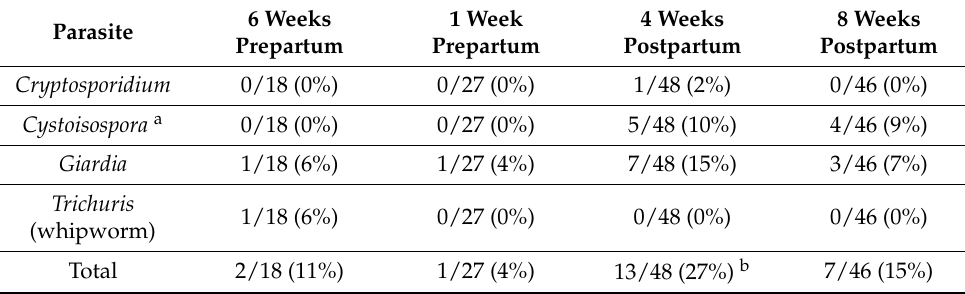
Table 3. Classification and number of parasites detected at each time point.